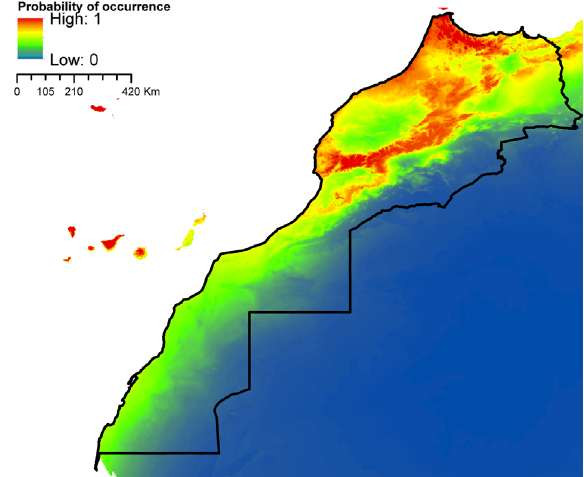
Figure 1. Predicted probability of Ae. aegypti occurrence in Morocco.